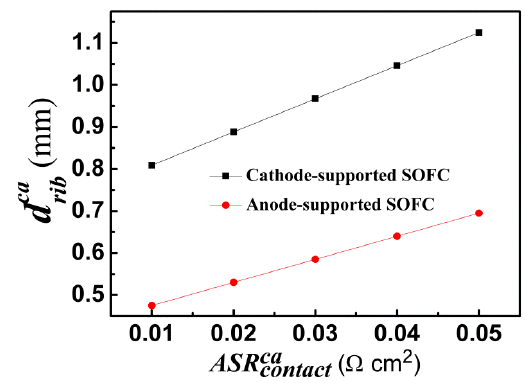
Figure 8. The optimal cathode rib width of anode- and cathode-supported